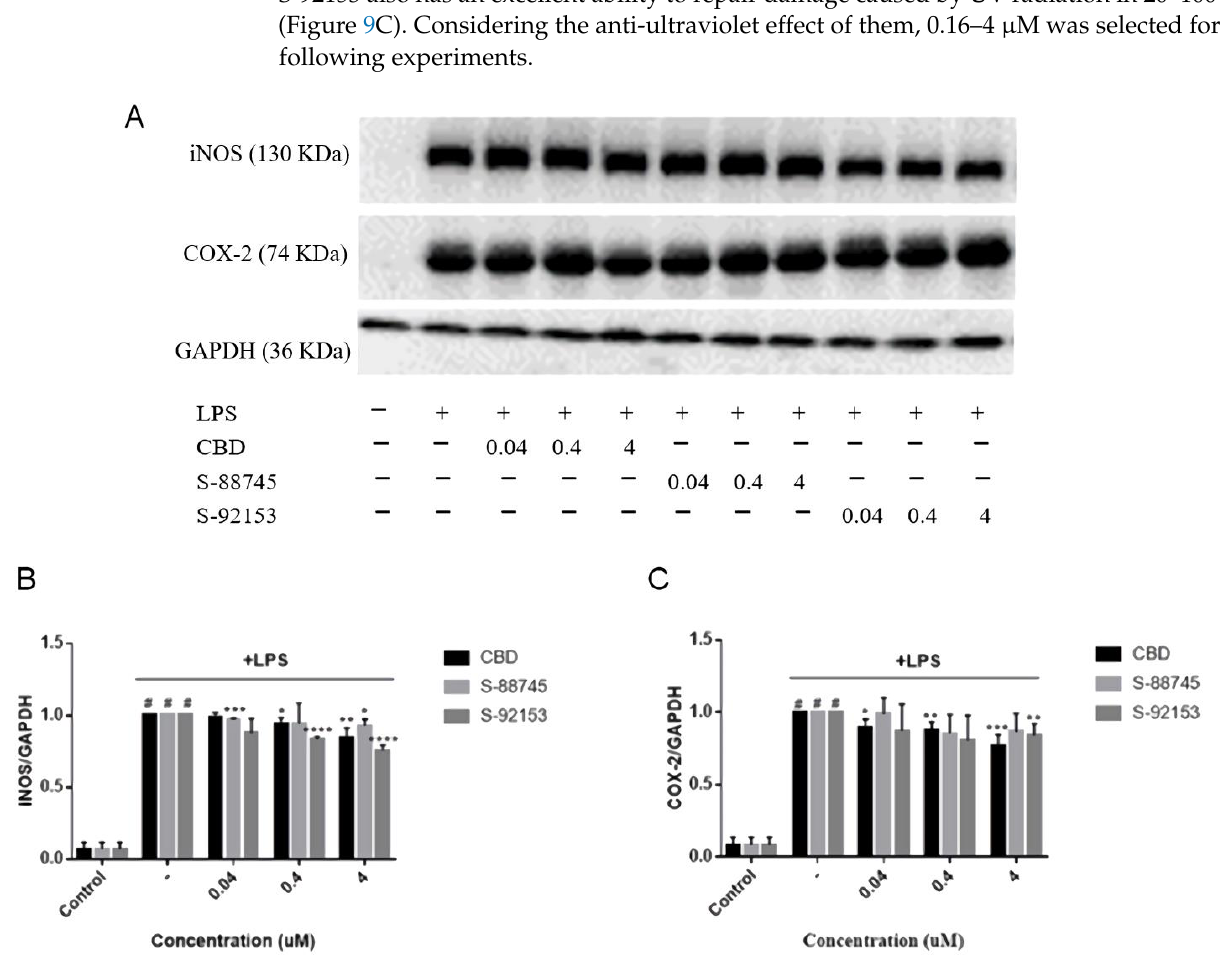
Figure 7. Effects of CBD, S-88745 and S-92153 on the expression of iNOS and COX-2 induced by LPS. In addition to an untreated control group and the LPS − treated group, RAW264.7 cells pretreated with CBD, S-88745 and S-92153 at 0.04, 0.4, and 4 µ M for 1.5 h, and then treated all groups with LPS, except the control group for 20 h. The levels of iNOS and COX-2 in the culture supernatants of RAW264.7 macrophages were then detected by western blot. ( A ) iNOS and COX-2 protein expression levels. ( B ) Relative ration analysis of iNOS expression. ( C ) Relative ration analysis of COX-2 expression. The experiments were repeated three times. Each bar illustrates the average ± standard deviation (SD) counted from three experiments. p < 0.05 was considered statistically significant. * p < 0.05 compared to the LPS − treated group; ** p < 0.01 compared to the LPS − treated group; *** p < 0.001 compared to the LPS − treated group; **** p < 0.0001 compared to the LPS − treated group; # p < 0.0001 compared to the control